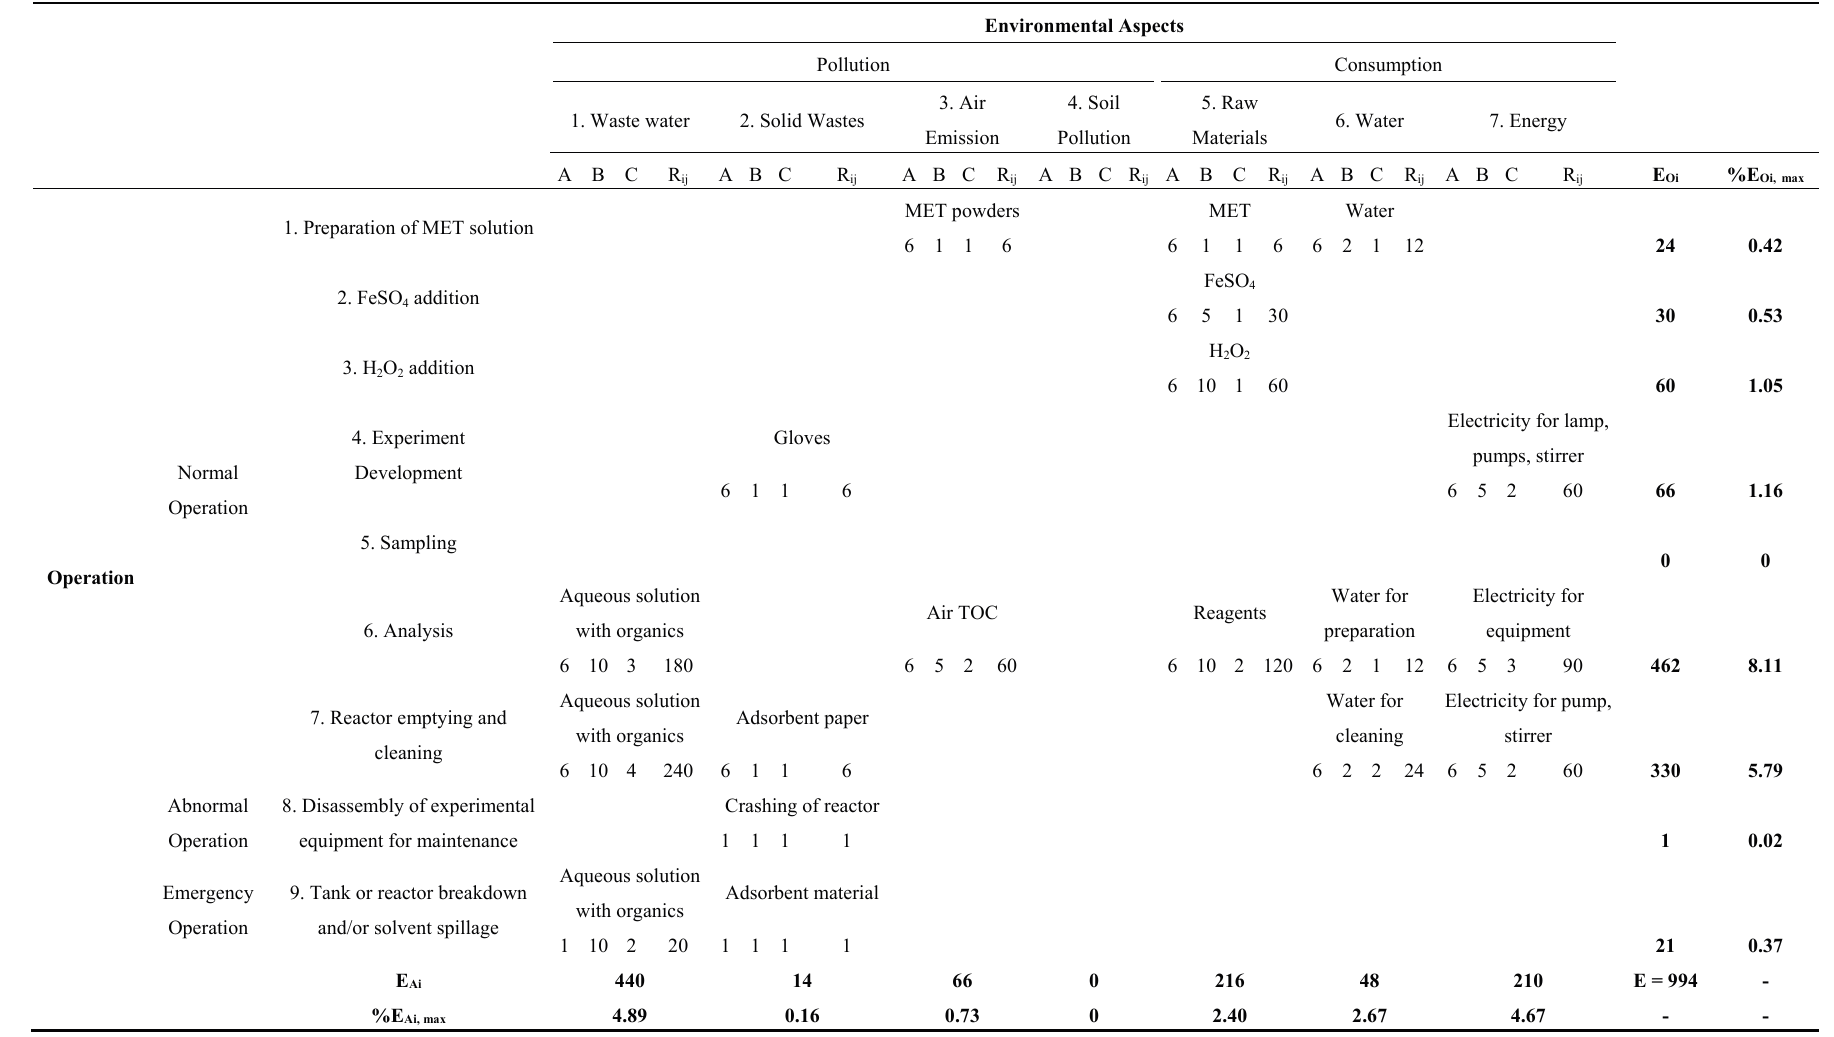
Table 10. Environmental Risk Identification and Evaluation. Process tested: photo-Fenton MET treatment in the